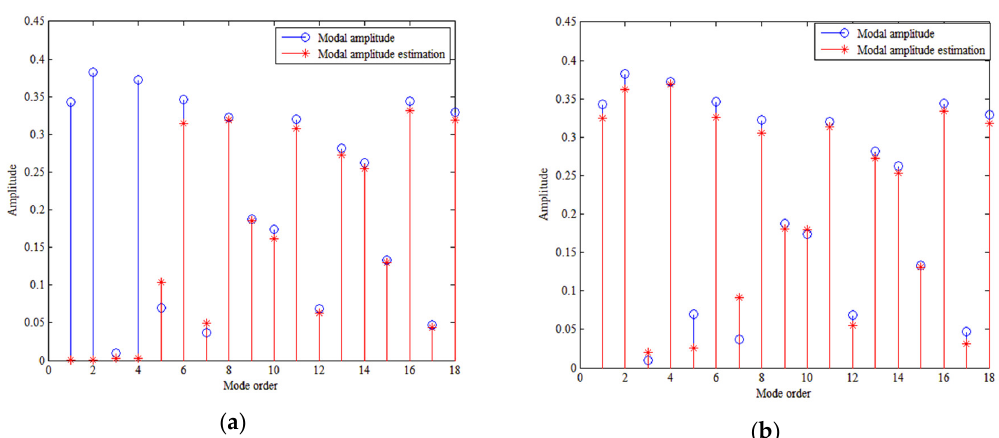
Figure 9. Modal amplitudes estimated by the TLS algorithm, when HLA depths are ( a ) 5 m and ( b ) 50 m. SNR is 20 dB.